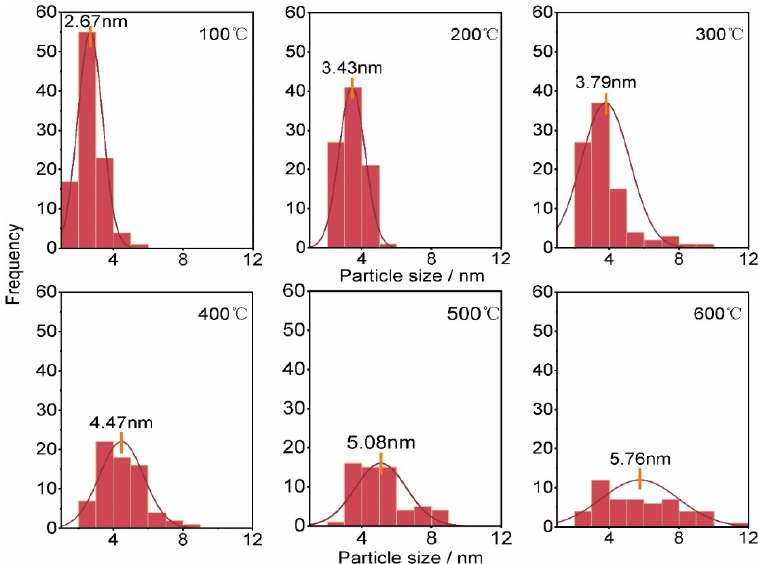
Figure 3. The distribution of the Pt particle size and corresponding fitted curves at different temperatures extracted from Figure 2, respectively. During the heating process, the number of particles gradually decreases and the average size increases due to the growth of nanograins.